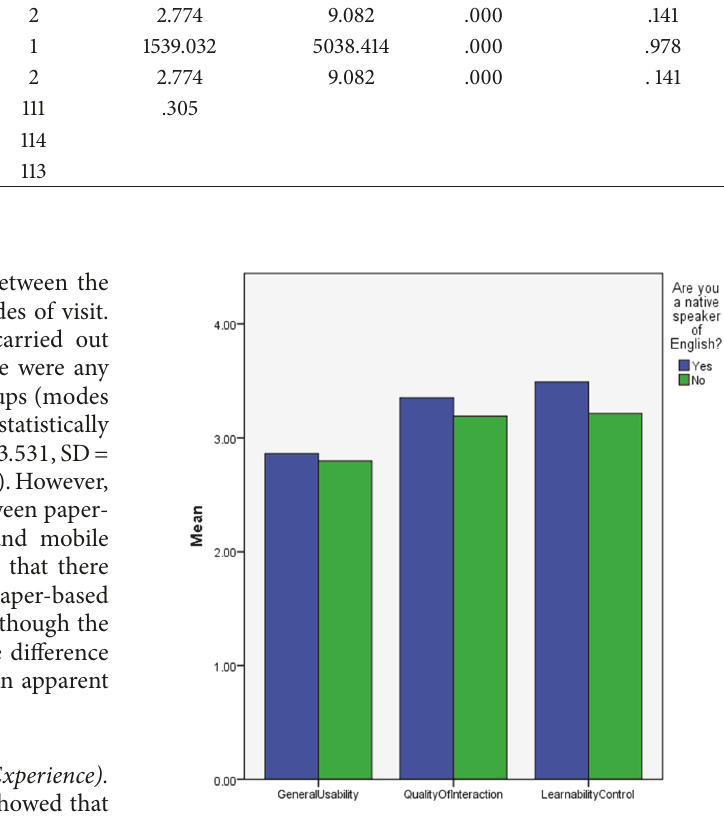
Figure 8: Mean scores of components in MMGS for native and nonnative